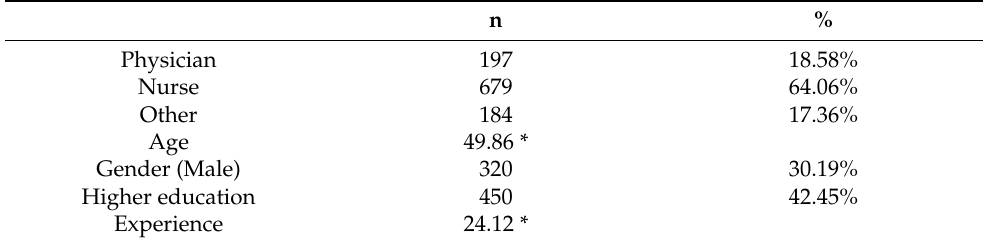
Table 1. Characteristics of study participants.